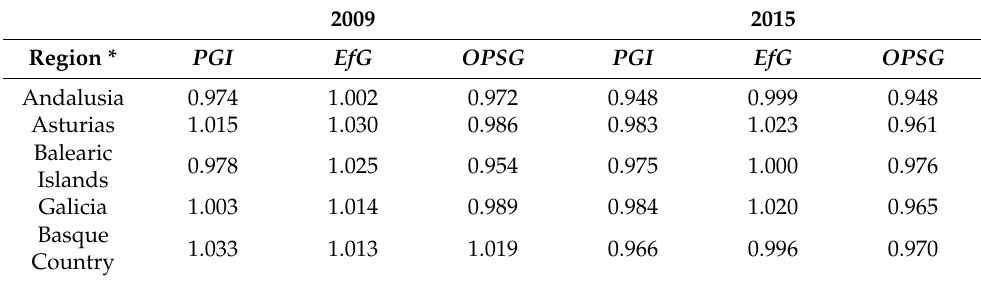
Table 4. PGI scores and decomposition.